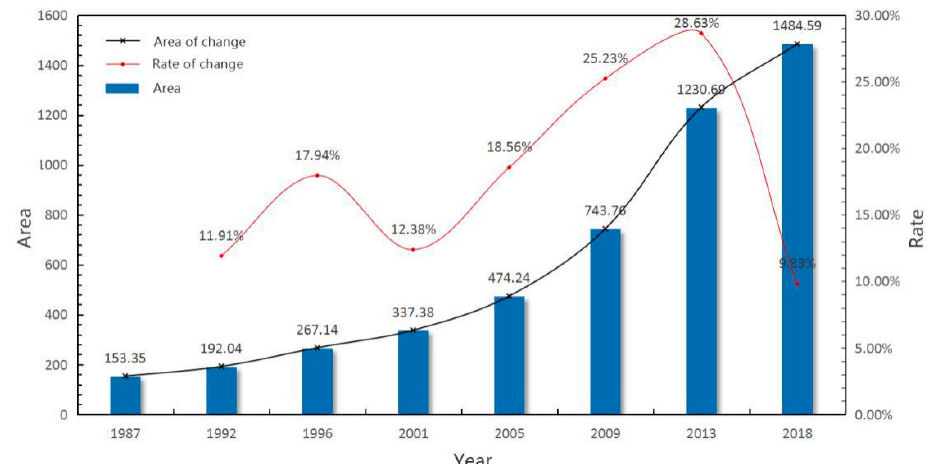
Figure 5. Statistics of urban built-up areas in Wuhan urban development area (1987–2018). The comparison of the statistical data of built-up areas every four years indicates that the built-up area increased year by year. The total area increased from 153.35 km 2 in 1987 to 1484.59 km 2 in 2018, increasing by 1331.24 km 2 in 30 years.